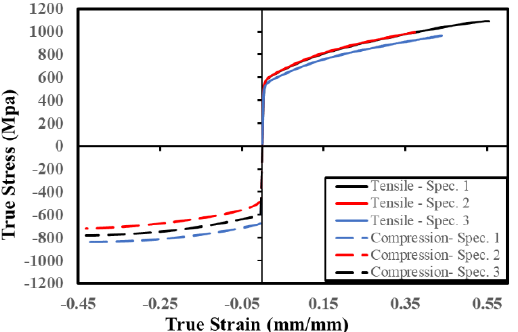
Fig. 5. Quasi-static strain-stress response of stainless steel 316L made by